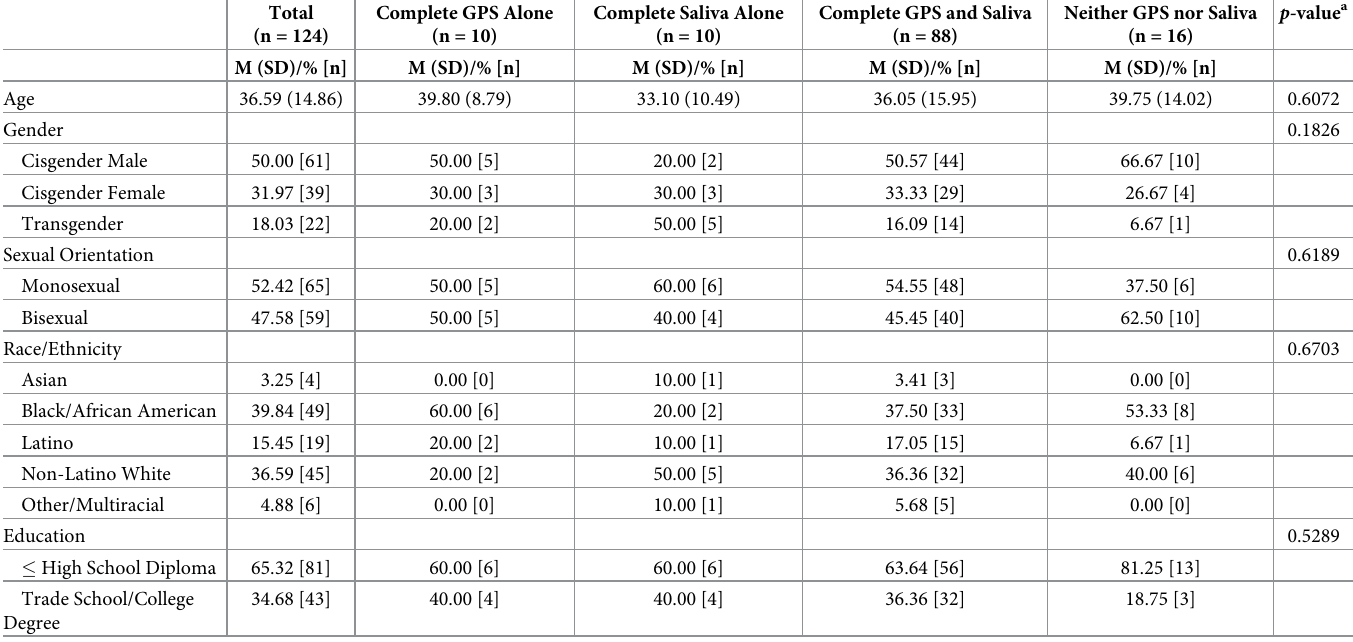
Table 1. Characteristics of participants by different types of data completion on participants providing entire 6 saliva samples including those who violated